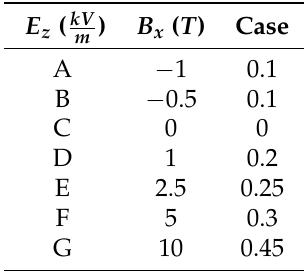
Figure 1. Sectional view of the vertical tube and boundary condition. Table 1. Various electric field and magnetic field